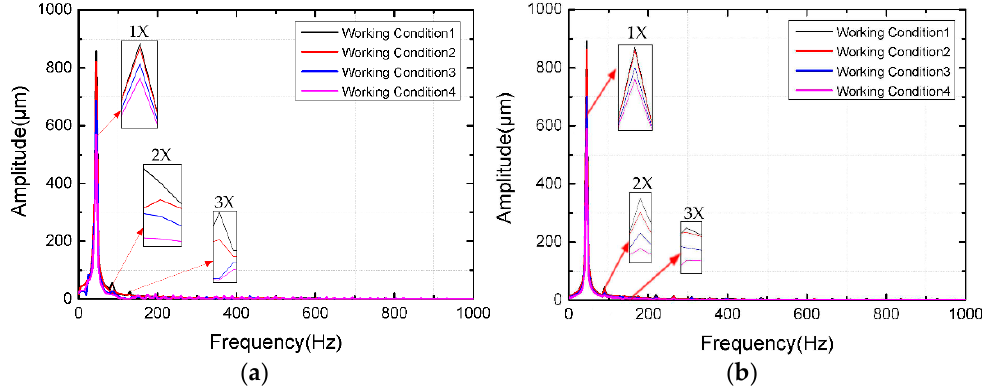
Figure 15. Vibration control of ISFBD in time domain spectrum: ( a ) theoretical results; ( b ) experimental results.